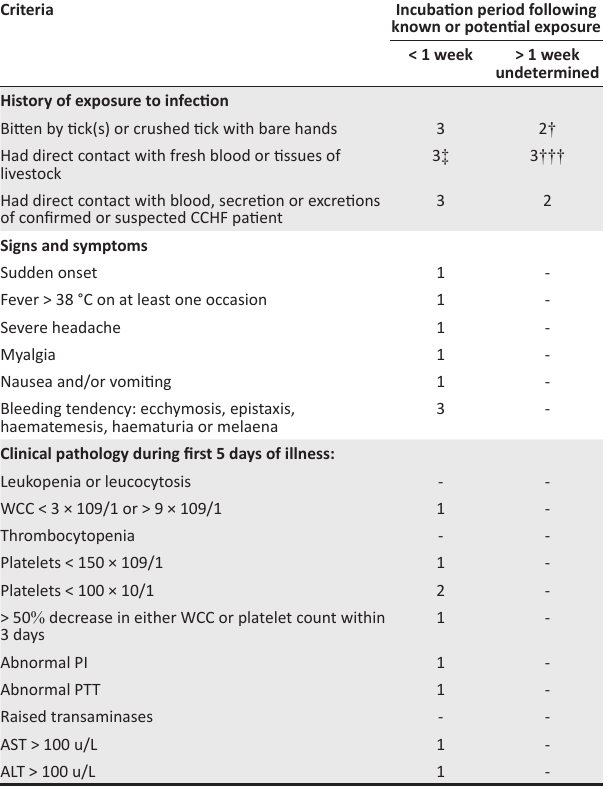
TABLE 1: Criteria for clinical diagnosis of Crimean-Congo haemorrhagic fever. Criteria